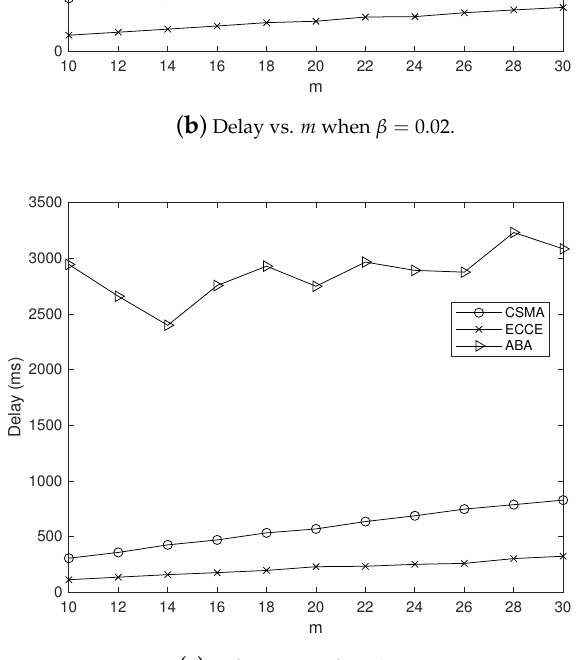
( c ) Delay vs. m when β = 0.04. Figure 6. The impact of m on delay when α =